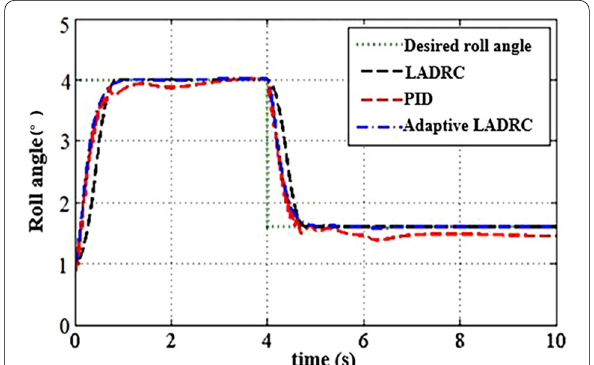
Figure 8 Comparison of three control methods